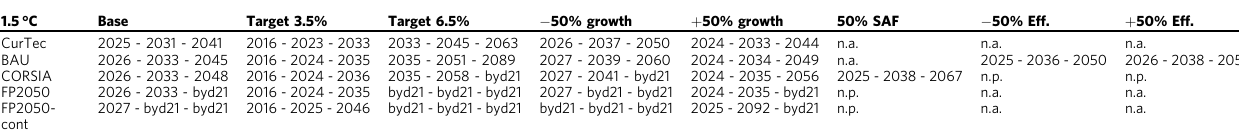
Table 4 Overview on sensitivities of the surpassing time with respect to the climate target, growth rate, use of sustainable aviation fuels and fuel ef fi ciency of new